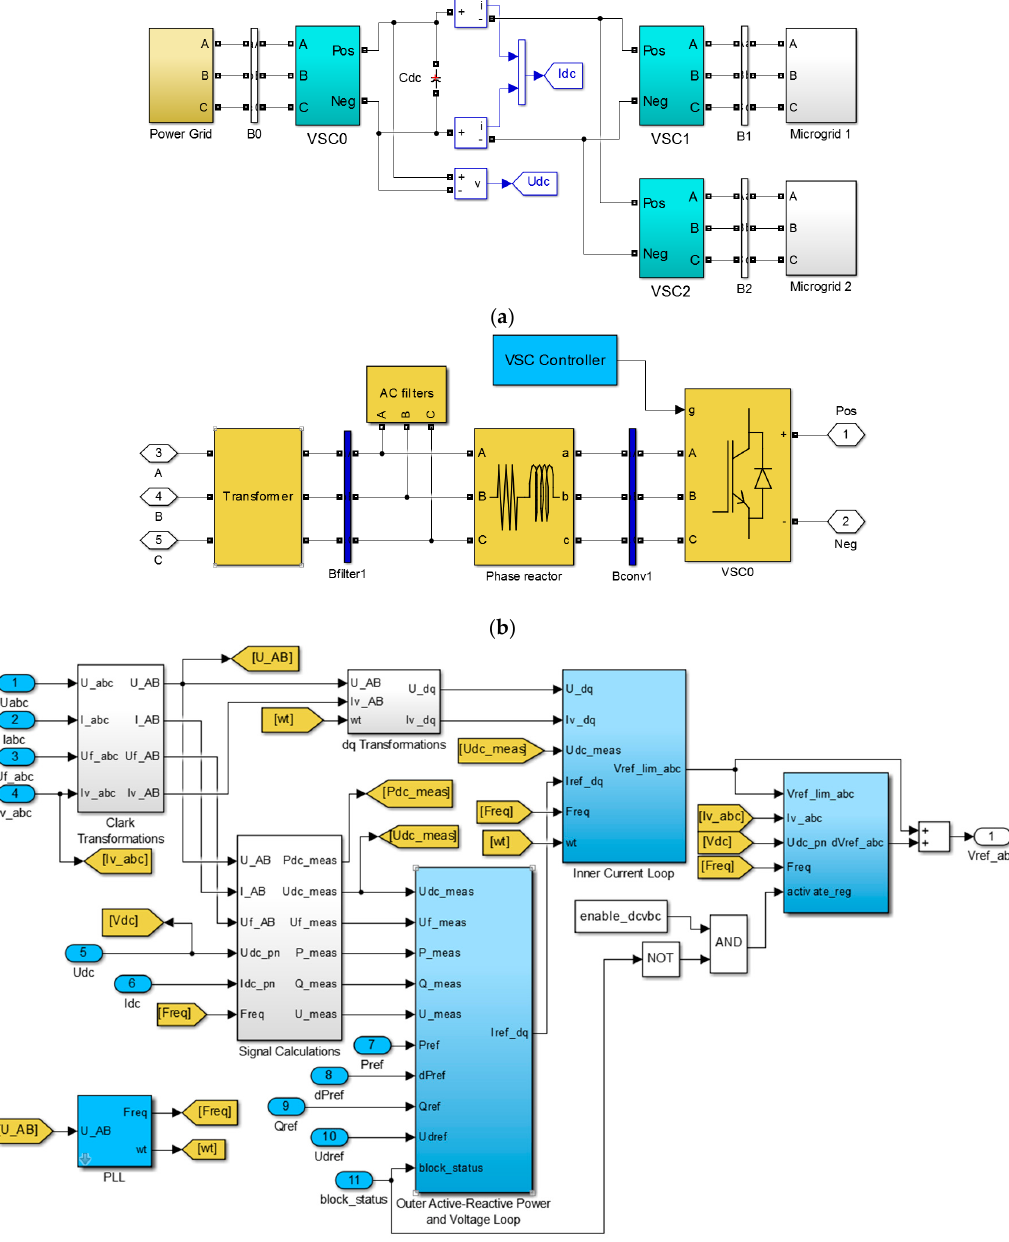
Figure 10. Simulation model of the interconnected microgrid system in MATLAB R2014b/Simulink platform: ( a ) overall simulation model; ( b ) VSC0 simulation model; and ( c ) VSC controller simulation model.